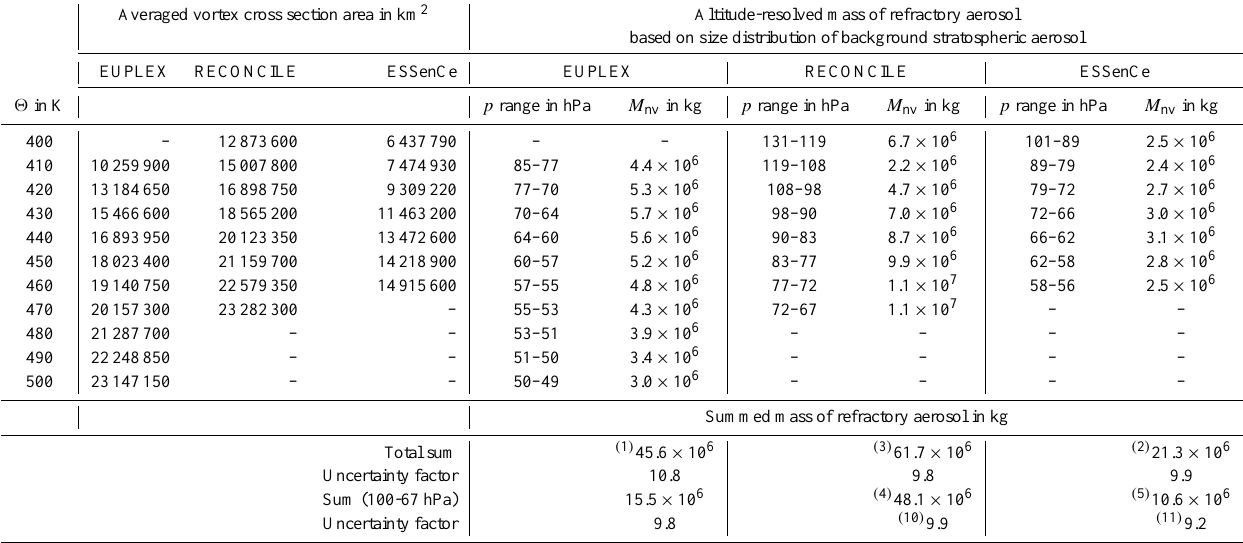
Table 3. Averaged vortex cross section areas from CLaMS analyses and resulting altitude-resolved refractory aerosol masses. The integrated aerosol masses inside the vortex are estimated from the in situ measurements under the assumptions detailed in Sect. 6. This estimate pro- vides an uppermost limit of refractory aerosol mass as it is based on size distributions of the background stratospheric aerosol parameterized from observations (cf. Sect. 2 and Jaenicke, 1980; Wang et al., 1989; Deshler, 2008). Vertical coordinates are given as potential temper- atures and the corresponding pressure ranges from the (cid:50) – p relationship are provided in Table 2. By applying specific uncertainty factors q M max nv /M min nv ) the extremes of involved uncertainties are covered. Indices ( ∗ ) simplify the traceability of the data’s origin in the (